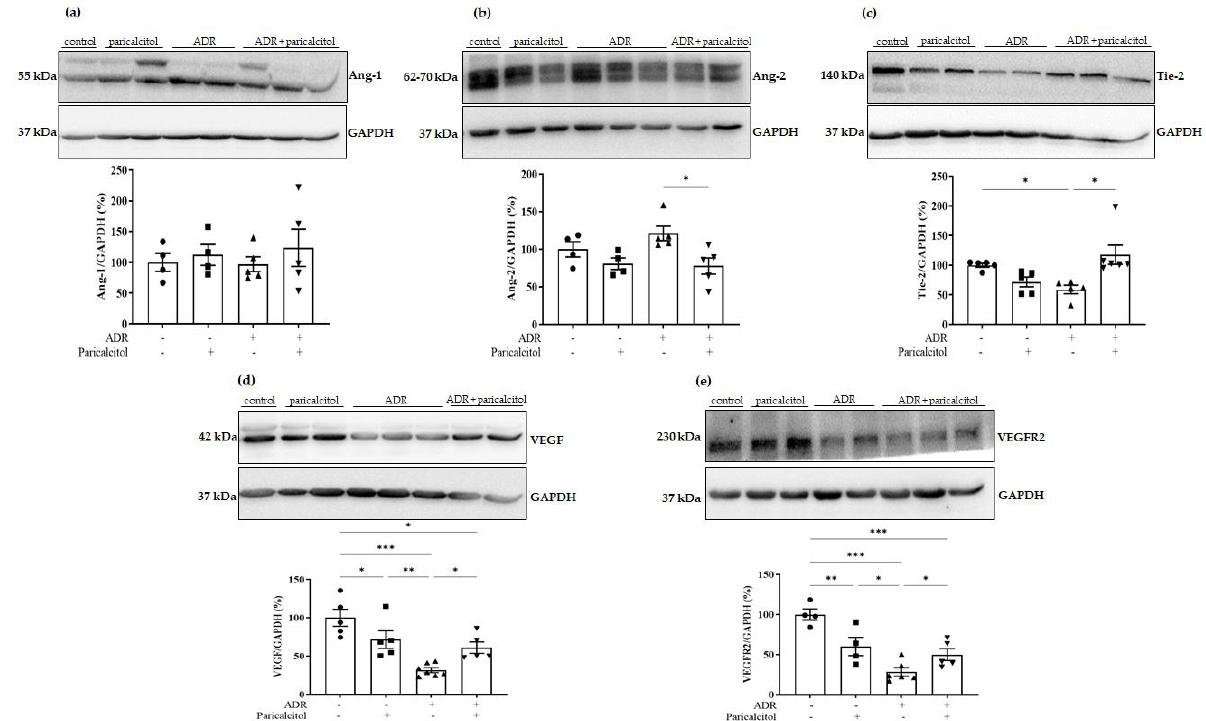
Figure 10. Pro- and anti-angiogenic factors. ( a ). Densitometric ratios among Ang-1. ( b ). Densito- metric ratios among Ang-2. ( c ). Densitometric ratios among Tie-2. ( d ). Densitometric ratios among VEGF and ( e ). Densitometric ratios among VEGFR2. Densitometric ratios among these markers and GAPDH were calculated, and data were expressed compared with the control group. The control value was designated as 100%. Data are expressed as mean ± SEM. n = 5–7 for each group. Data from the control (dots), paricalcitol (squares), ADR (up triangles), and ADR + paricalcitol (down triangles) groups. * p < 0.05; ** p < 0.01; *** p < 0.001.